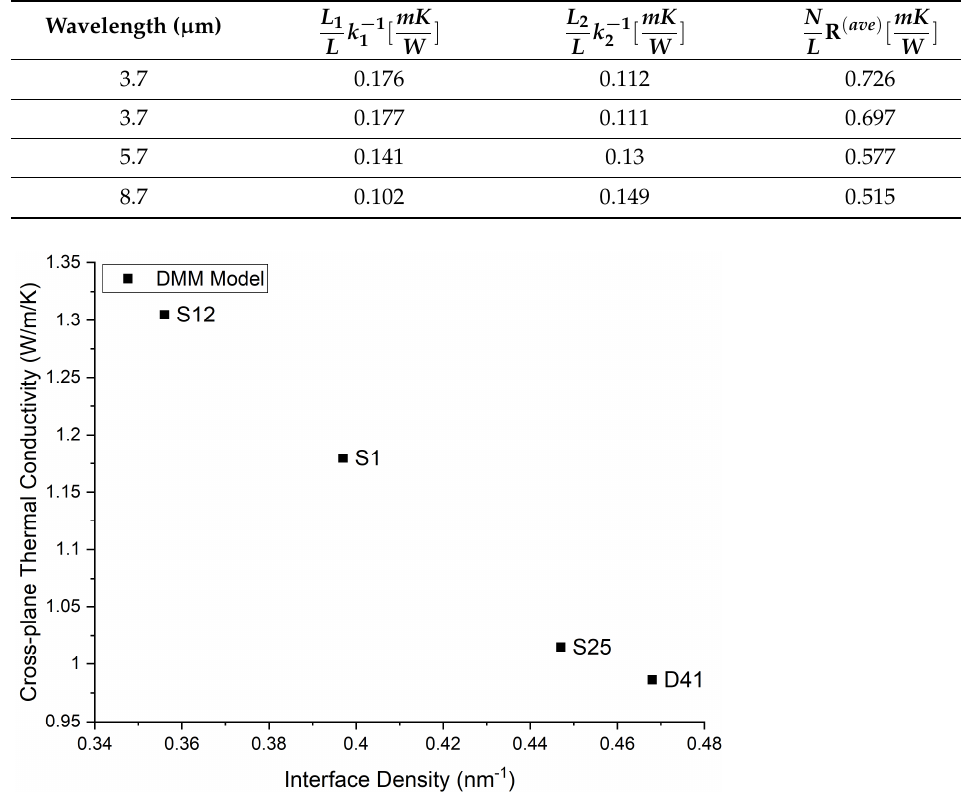
Table 4. Values for each term in cross-plane thermal conductivity calculation.